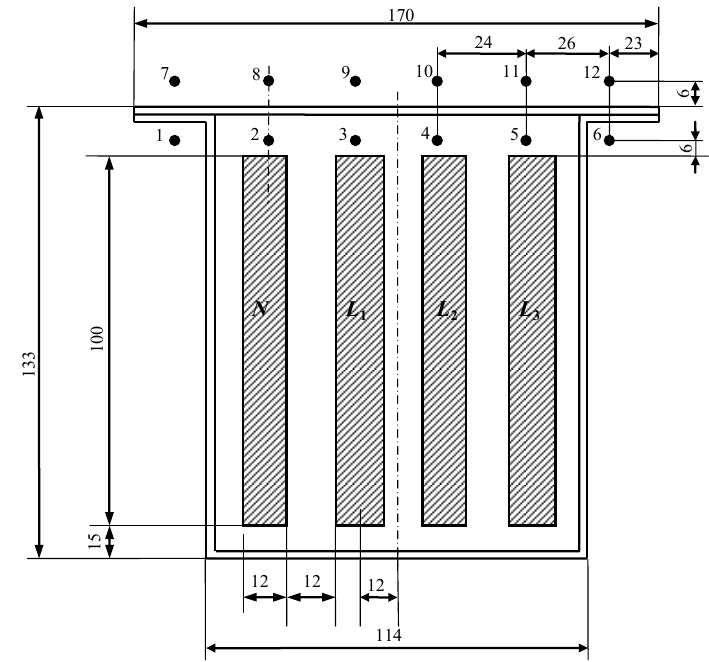
Figure 17. The location of measurement points of a shielded (unshielded) busbar system. Table 3. Magnetic field intensity (in kA/m) at selected points of an unshielded (u) and shielded (s) three-phase busbar system manufactured by Holduct with current symmetry of I = 1 kA .